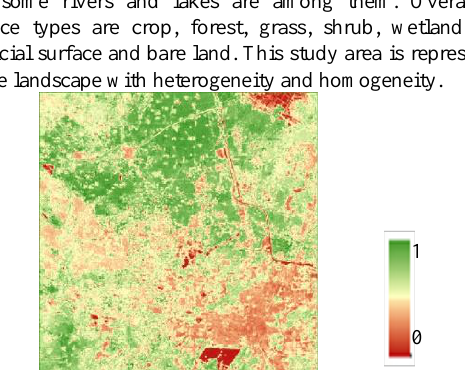
Figure 3. 30m NDVI of Shandong area